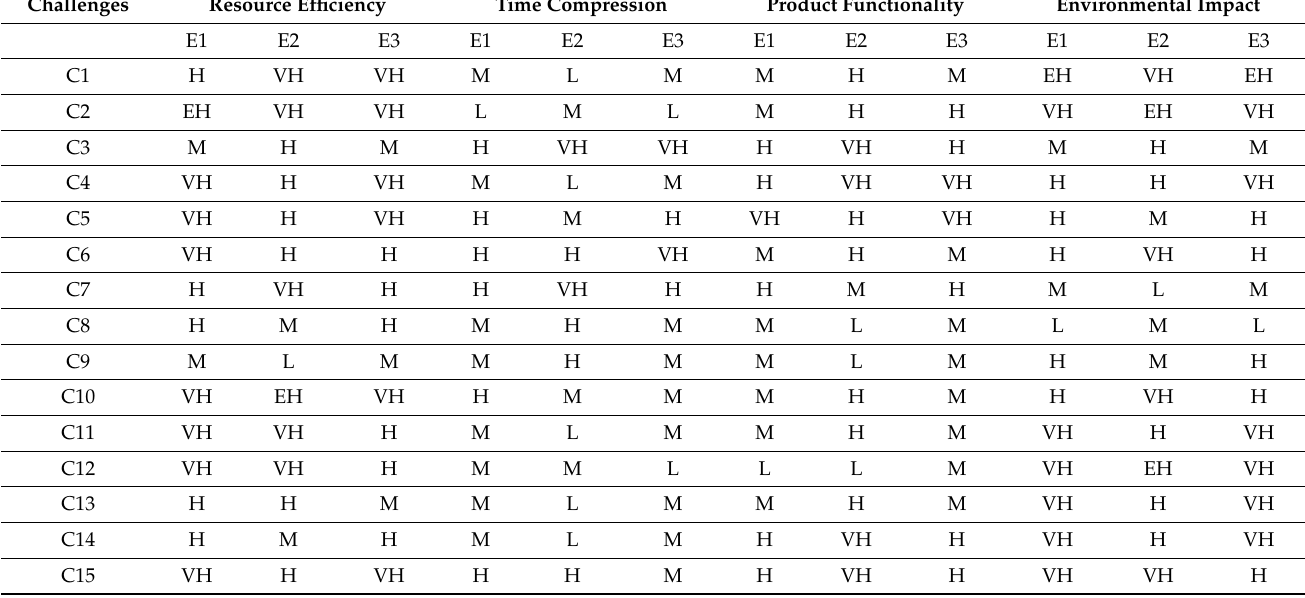
Table 3. Input rating of challenges based on each